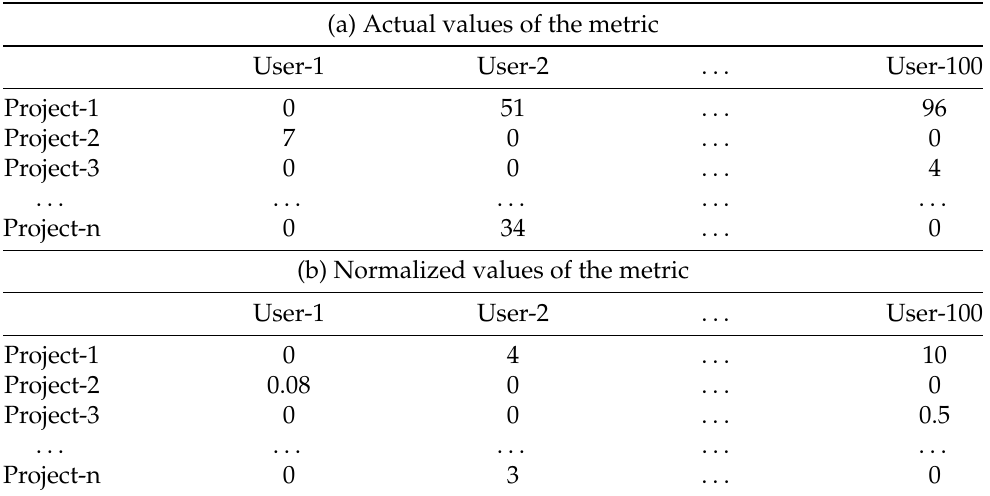
Table 3. A sample project-developer matrix belongs to the metric issue_opened